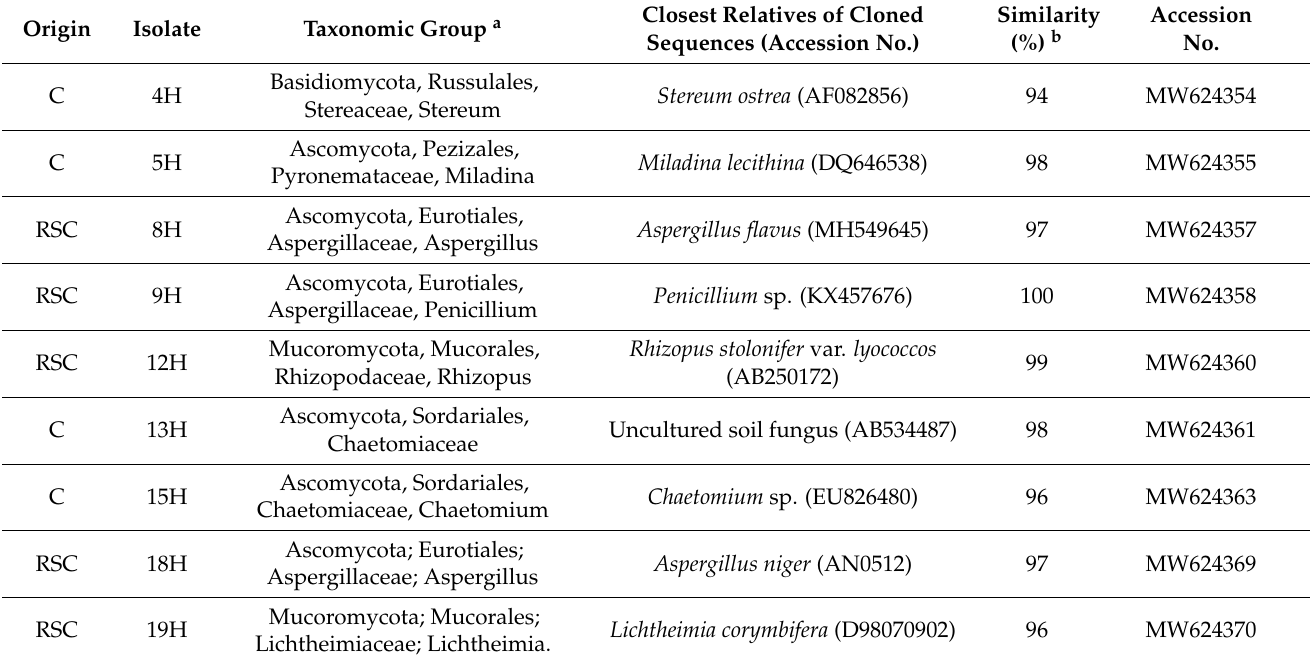
Table 3. Taxonomic assignment of fungal isolates which did not showed associated bacteria, using the fungal highway column system (FHCS) selection and isolation approach. C and RSC refer to compost and rhizosphere soil with compost application, respectively.